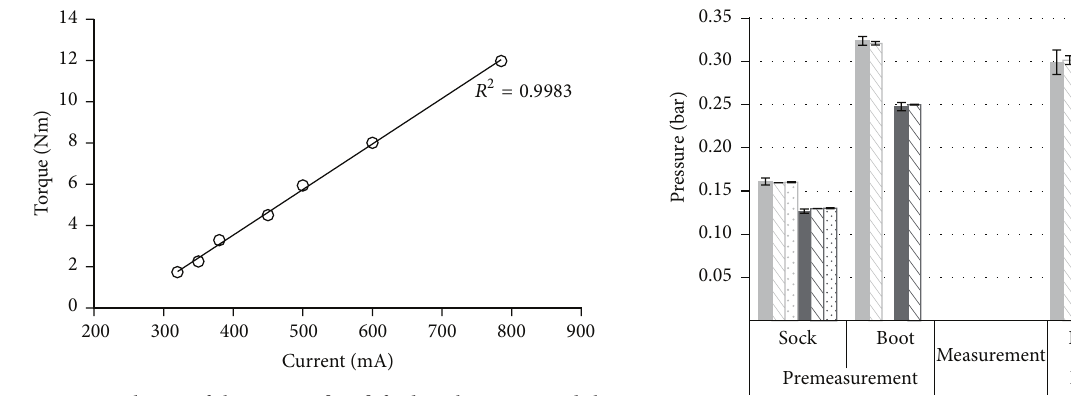
Figure 2: Relation of the current [mA] feed to the motor and the resulting output torque [Nm] including the linear regression (𝑦 = 0.0221 × −5.2961) . repeated for the testing movements in the frontal plane (eversion/inversion).